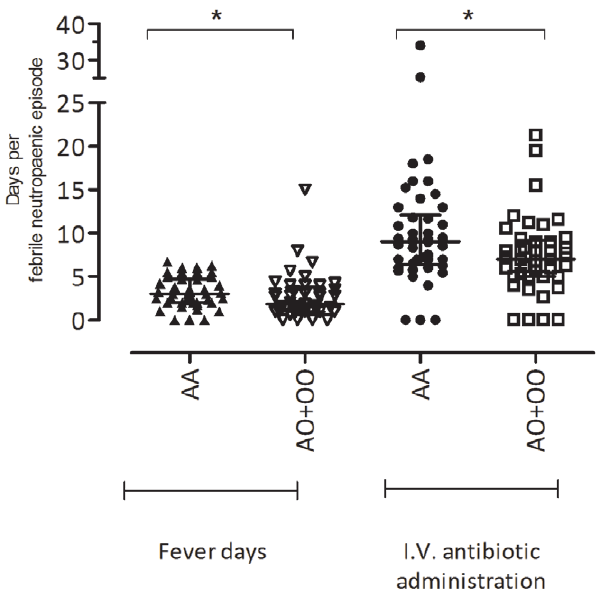
Figure 3. The proportional days of fever and days of antibiotic treatment during febrile neutropaenia episodes among A/A (n=46) and A/O + O/O (n=41) individuals. ( * p , 0.05).